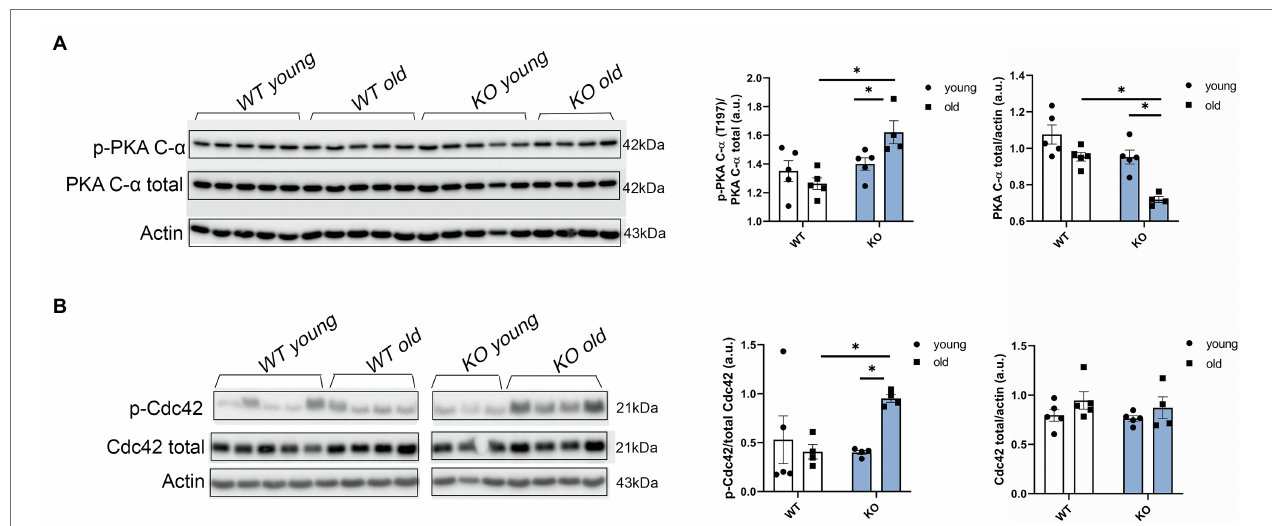
FIGURE 6 | Protein kinase A (PKA) phosphorylation and Cdc42 phosphorylation are increased in aged KO mice. (A) Phosphorylation of catalytic (C)- α subunit at Thr197, total PKA, and actin as loading control was detected by Western blot. Aged KO mice show increased quantification of PKA phosphorylation at Thr197 over total PKA. (B) Representative images of the phosphorylation levels of Cdc42 at Ser71 detected by Western blot. Due to a strong phospho Cdc42 signal that was difficult to strip and both phospho and total antibodies being from rabbit, we used a separate blot to detect total Cdc42 and actin as loading control. Quantification of Cdc42 phosphorylation at Ser71 over total Cdc42 shows increased phosphorylation levels in aged KO mice. Young: 3–6 months and old: 12–16 months. Data presented as mean ± SEM. N = 4–5. Outliers were identified with the ROUT method and excluded from analyses. Data were analyzed with a two-way ANOVA post-hoc Fisher’s LSD test. * p <